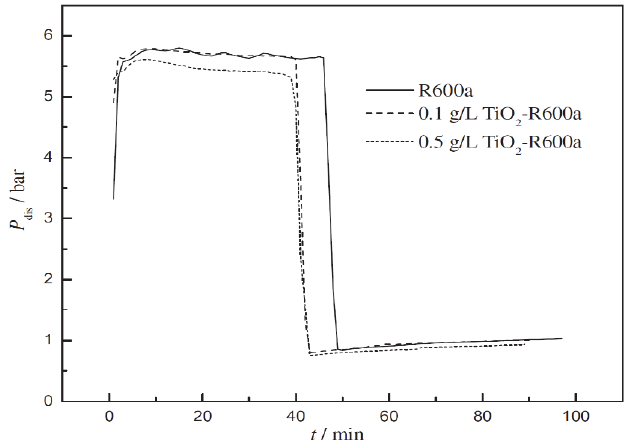
Figure 15. Compressor discharge pressure [42].